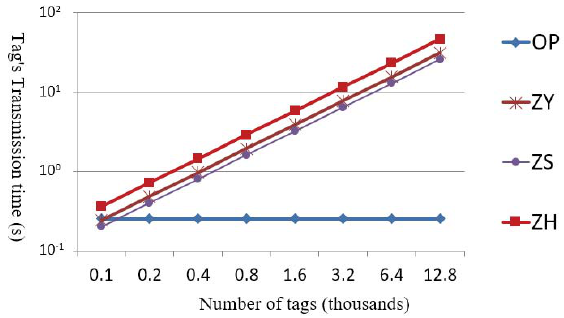
Figure 9. Comparisons of transmission load of tags.